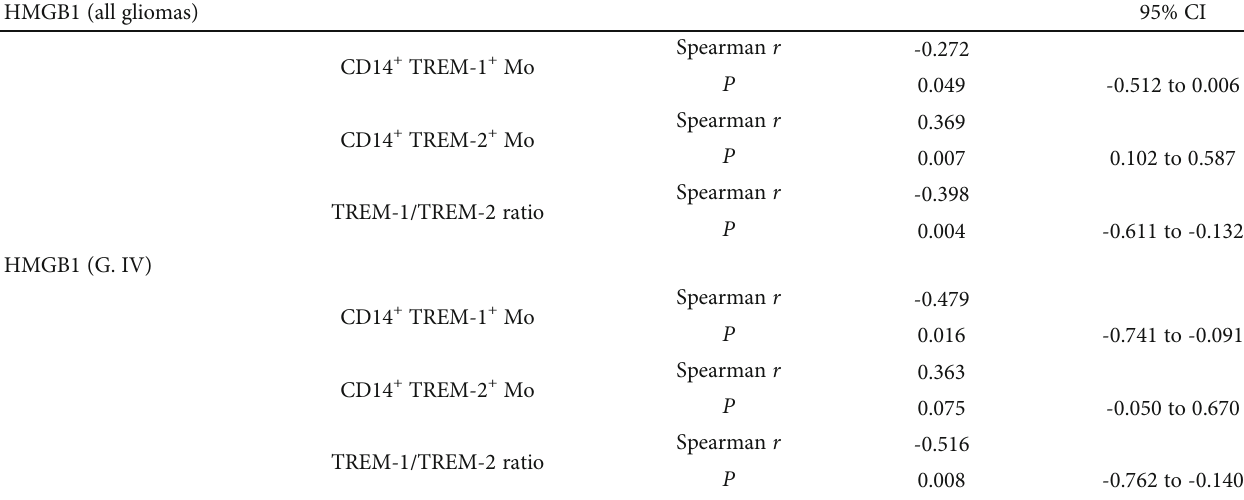
Table 3: Correlations of the serum levels of HMGB1 with percentage of CD14 + TREM-1 + , CD14 + TREM-2 + monocytes, and TREM- 1/TREM-2